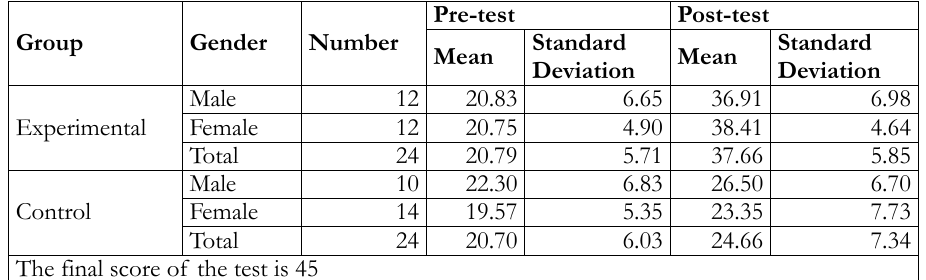
Table 1. Means and standard deviation of the pre and post test scores for the experimental and control groups according to the variables of the group and gender